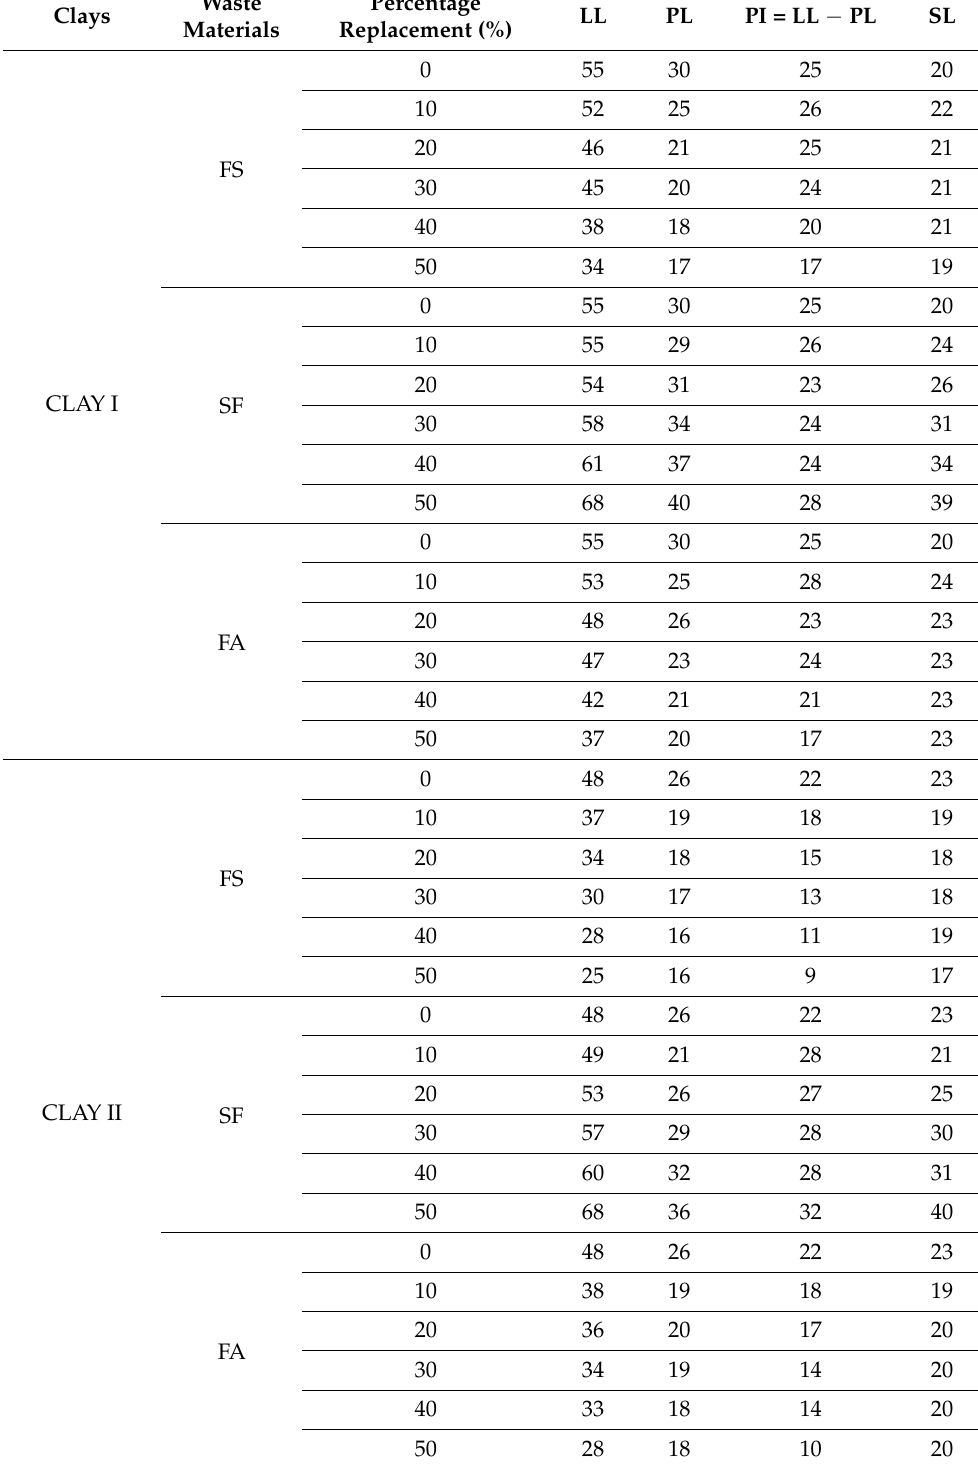
Table A2. Index properties of FS, SF, and FA modified